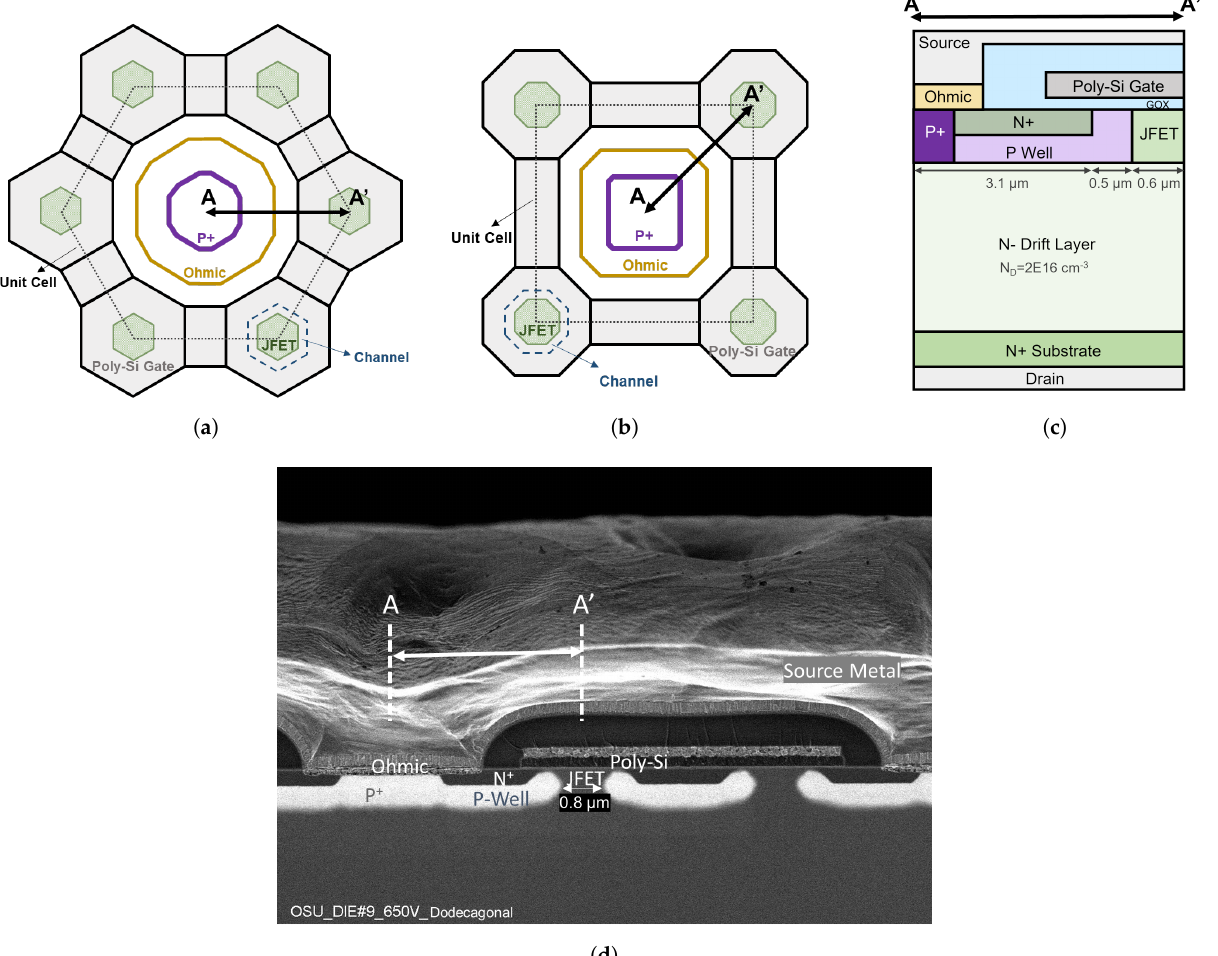
Figure 1. ( a ) Dodecagonal cell topology, ( b ) Octagonal cell topology, ( c ) A-A’ cross-sectional view of the 650 V SiC power MOSFET. ( d ) Cross-sectional SEM image of the fabricated 650 V SiC power MOSFET with the Dod